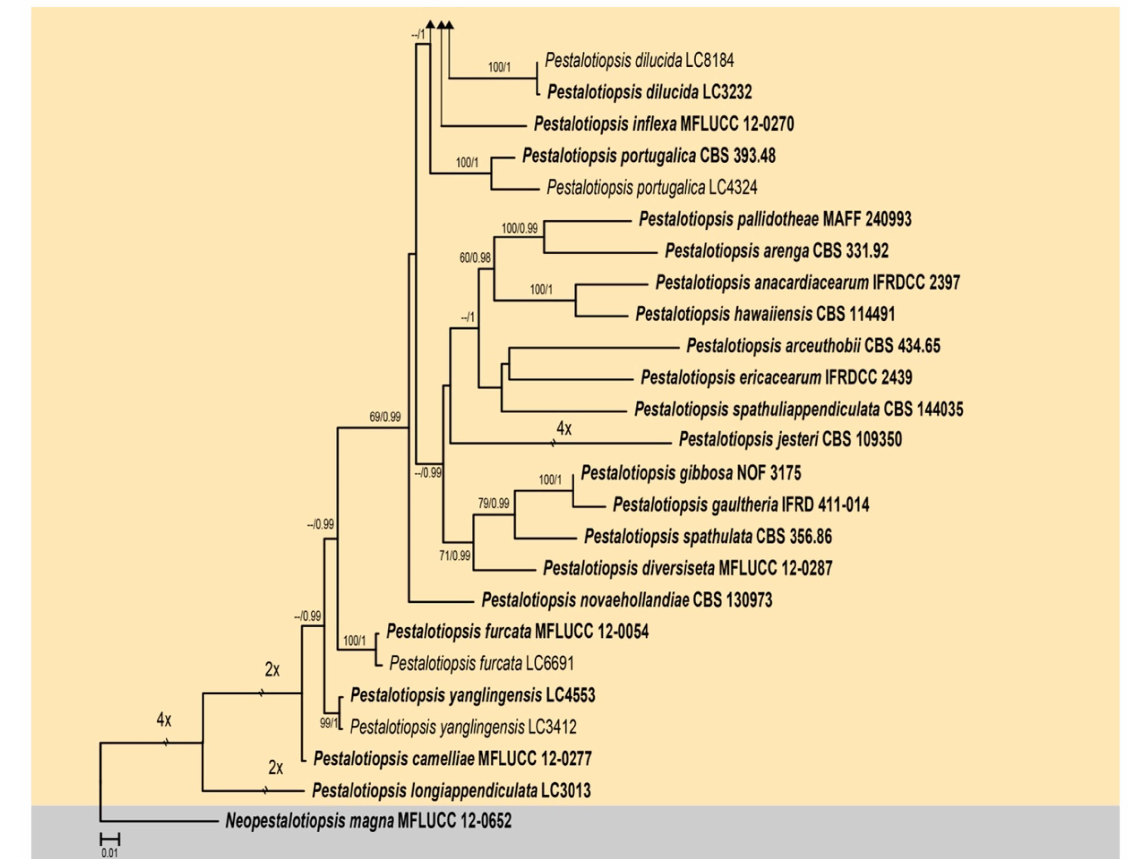
Figure 3. Phylogram generated from RAxML analysis based on combined ITS, tef1- α , and tub2 sequence data of Pestalotiopsis isolates. The tree was rooted to Neopestalotiopsis magna (MFLUCC 12-0652). The ML, MP bootstrap supports ( ≥ 60%) and BI posterior probabilities ( ≥ 0.90 PP) supports are given near the nodes, respectively. Isolates from this study are marked in red and ex-type strains are marked in